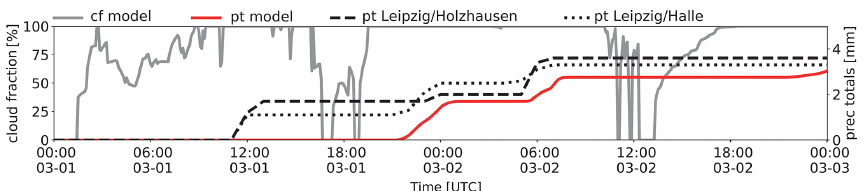
Figure 10. Modeled cloud fraction (cf, full gray line) and cumulative precipitation totals (pt, full red line) for Leipzig based on simulation M3. In addition, cumulative precipitation totals are shown for the meteorological sites Leipzig/Holzhausen (51.3151 ◦ N, 12.4462 ◦ E, dashed line) and Leipzig/Halle (51.4348 ◦ N, 12.2396 ◦ E, dotted